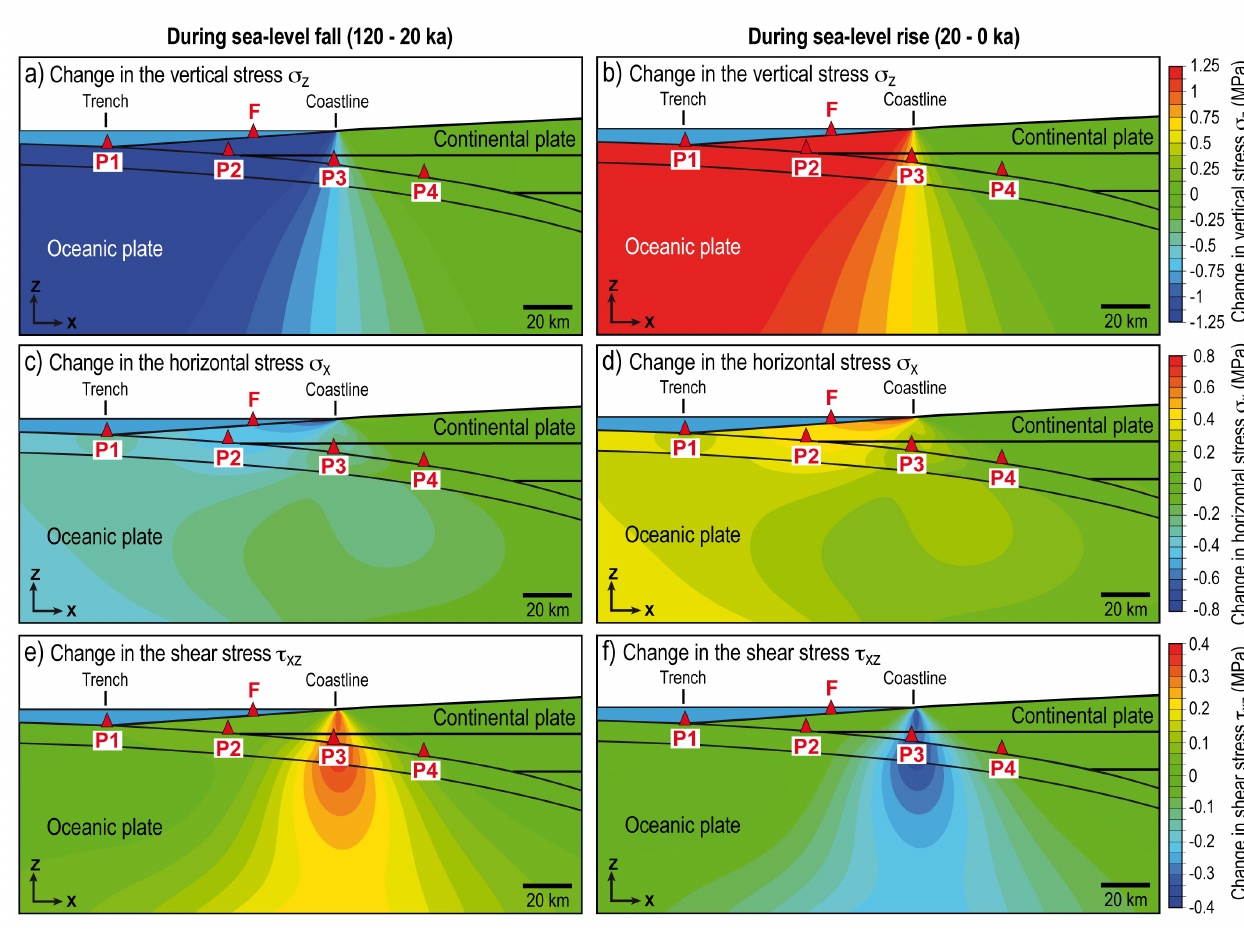
Fig. 4. Stress variations caused by the sea-level changes. Left column shows the change in (a) the vertical stress σ z , (b) horizontal stress σ x and (c) shear stress τ xz during sea-level fall (120–20ka). Right column shows the change in (b) the vertical stress σ z , (d) horizontal stress σ x and (f) shear stress τ xz during sea-level rise